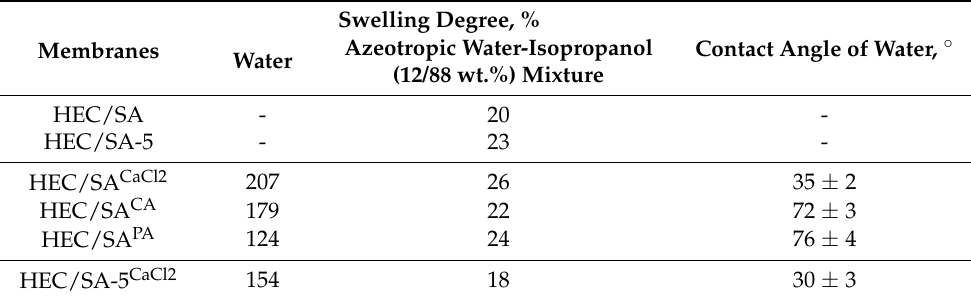
Table 5. Swelling degree and contact angle of water for the HEC/SA membranes. Swelling Degree, Membranes